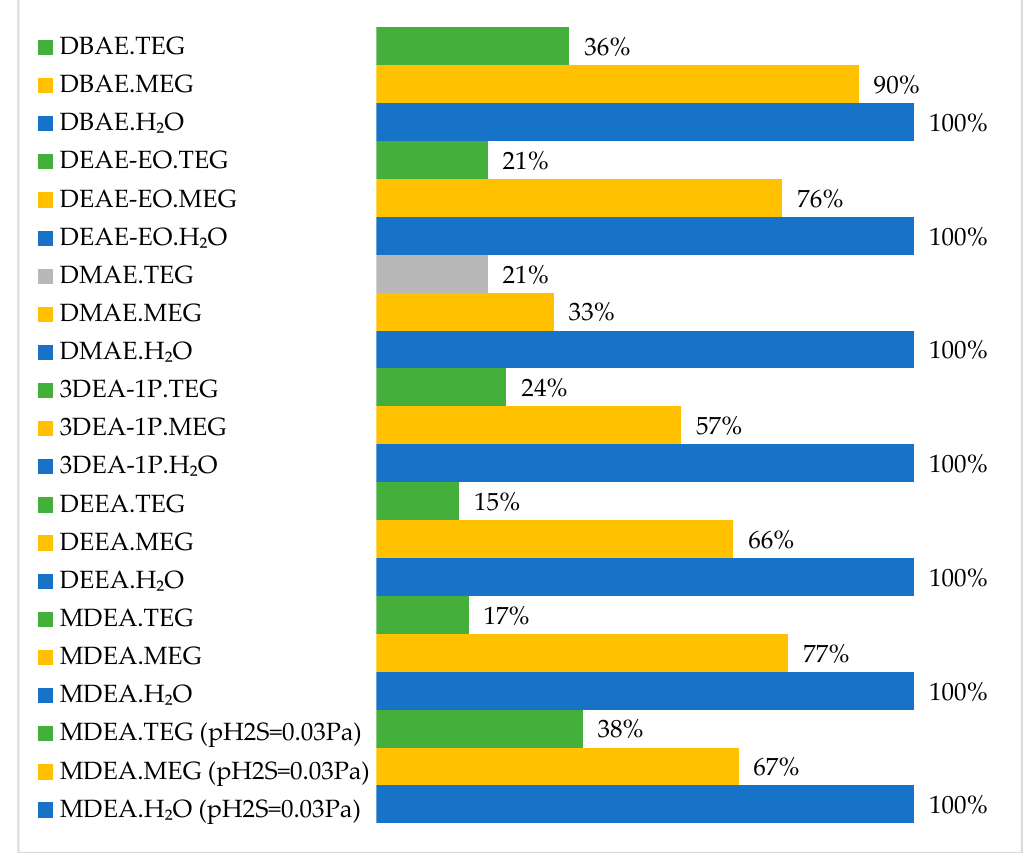
Figure 6. Effect of solvent on absorbed H 2 S; T = 5 °C ± 0.1 °C; pH 2 S = 1 kPa; mine concentration = 20 wt.% (unloaded); DBAE solutions makes two phases.